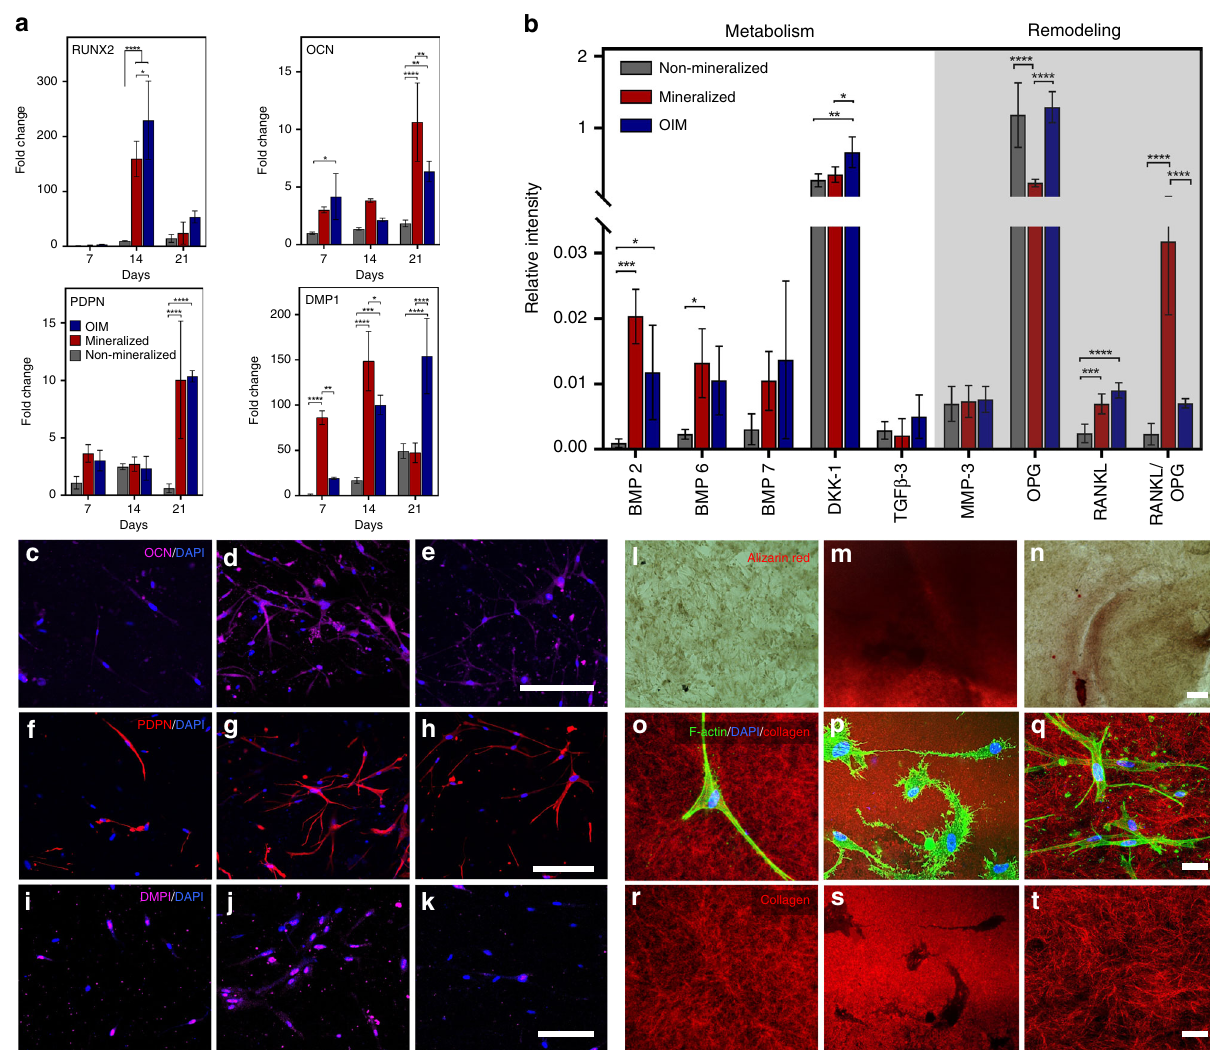
Fig. 3 Osteogenic lineage commitment, gene, and protein expression in mineralized cell-laden collagen. a Gene expression of osteocalcin ( OCN ) was signi fi cantly higher (** p < 0.01) in mineralized collagen than in OIM treated, both of which were much higher than non-mineralized samples (**** p < 0.0001), after 21 days. Expression of osteocyte-related genes ( DMP1 and PDPN ) was also comparable to OIM after 21 days of culture in mineralized collagen and signi fi cantly higher at earlier time points ( DMP1 , ** p < 0.01 after 7 days and * p < 0.05 after 14 days). Data are represented as mean ± SD ( N = 3). b A signi fi cant increase in the expression of BMP-2 and BMP-6 for cells in both mineralized collagen and in OIM relative to non-mineralized controls is consistent with enhanced bone-speci fi c metabolic activity. A marked increase in the ratio of RANKL/OPG in mineralized samples, however, suggests the stronger potency for cell-mediated bone remodeling via a paracrine signaling in cell-laden mineralized constructs than in the other groups. ( N = 4 for BMPs and N = 5 for others). At a cell-surface level, the expression of OCN and PDPN on day 14 was very low in ( c , f ) non-mineralized controls and signi fi cantly higher for both ( d , g ) mineralized and ( e , h ) OIM-treated samples (** p < 0.01, *** p < 0.001) ( N = 3). Similarly, surface expression of DMP1 was comparable for ( k ) OIM-treated cells (**** p < 0.0001) and ( j ) mineralized collagen (* p < 0.05), both of which were signi fi cantly higher than ( i )